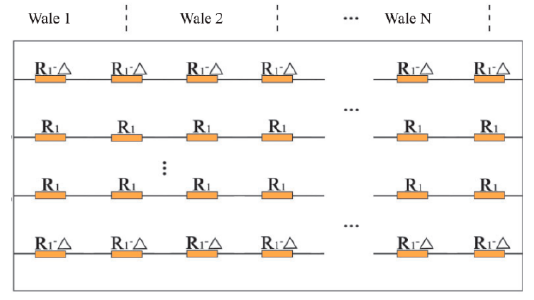
Figure 18. Simplified equivalent network model [68].